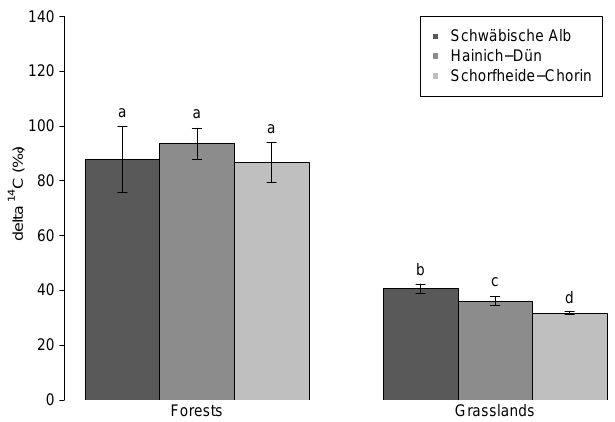
Fig. 2. Comparison of mean 1 14 C values of fine roots between grassland and forest sites across study regions ( p < 0.001). The columns denoted with different letters are significantly different ( p < 0.05). Error bars represent SE of means ( n =